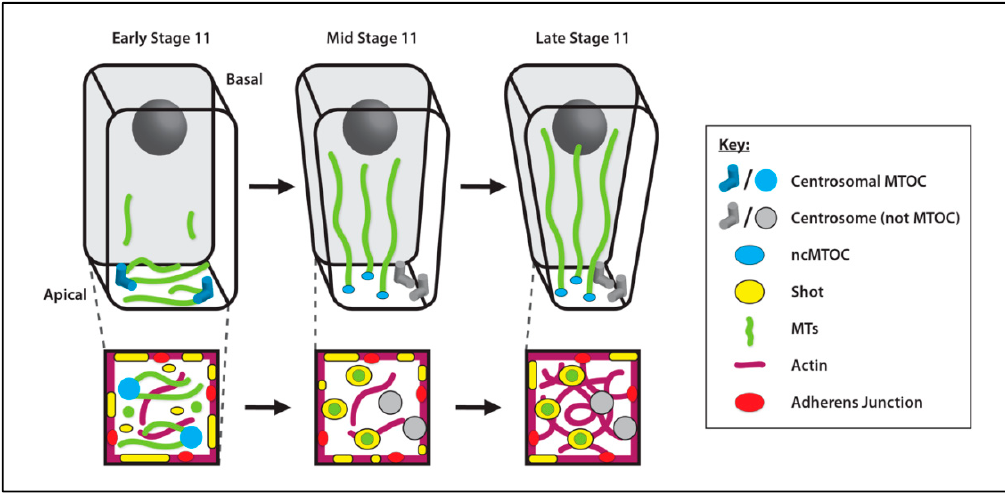
Figure 8. Salivary gland placode cell ncMTOC. In this cell type, the MTOC changes dynamically during embryonic stage 11 from a centrosomal MTOC to an apical membrane ncMTOC required for